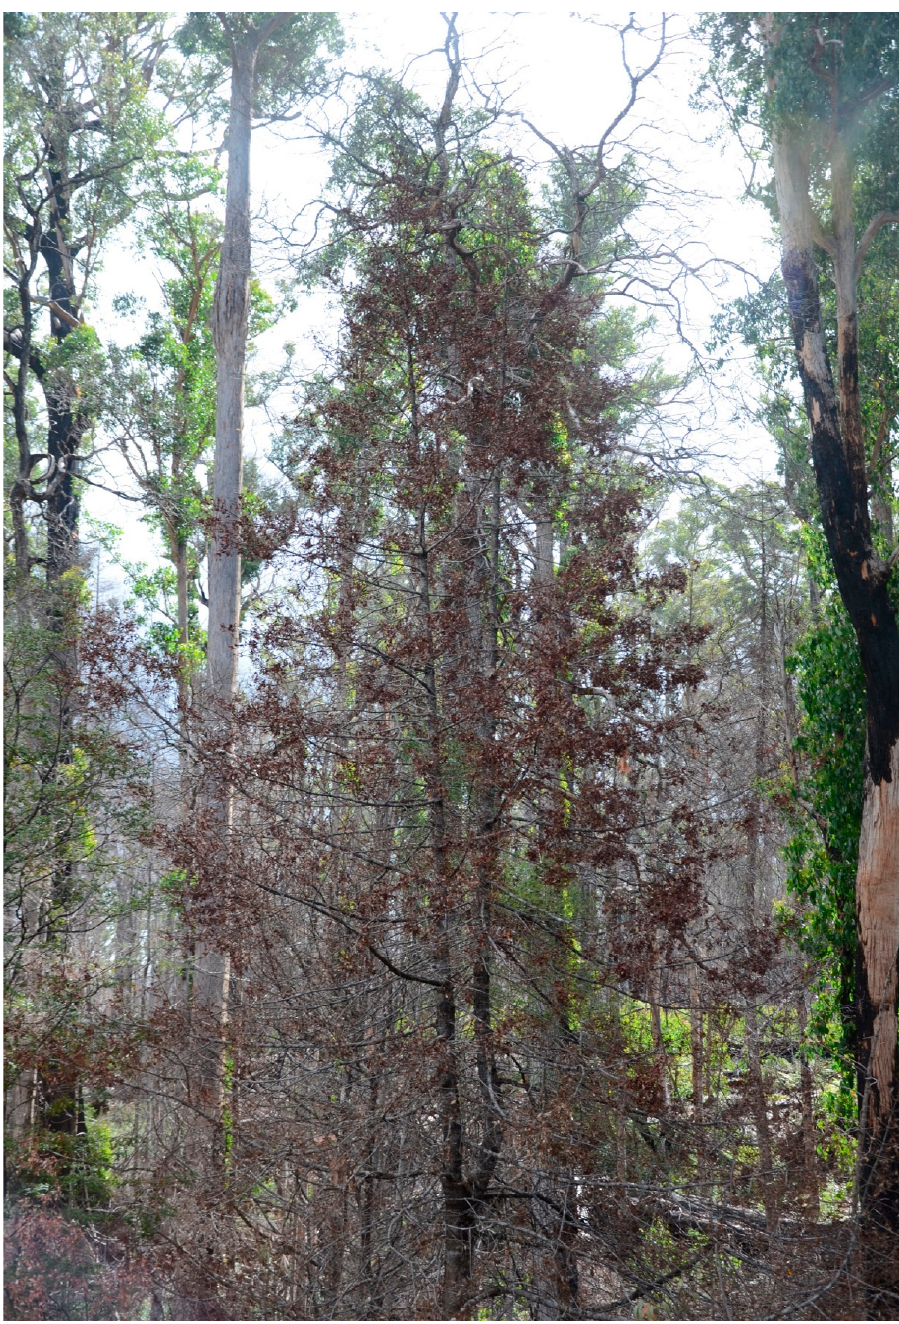
Figure 6. A wildfire in 2020 burnt the Tahune rainforest, Tasmania. This photo is of a burnt Celery-top Pine ( Phyllocladus aspleniifolius ) tree.